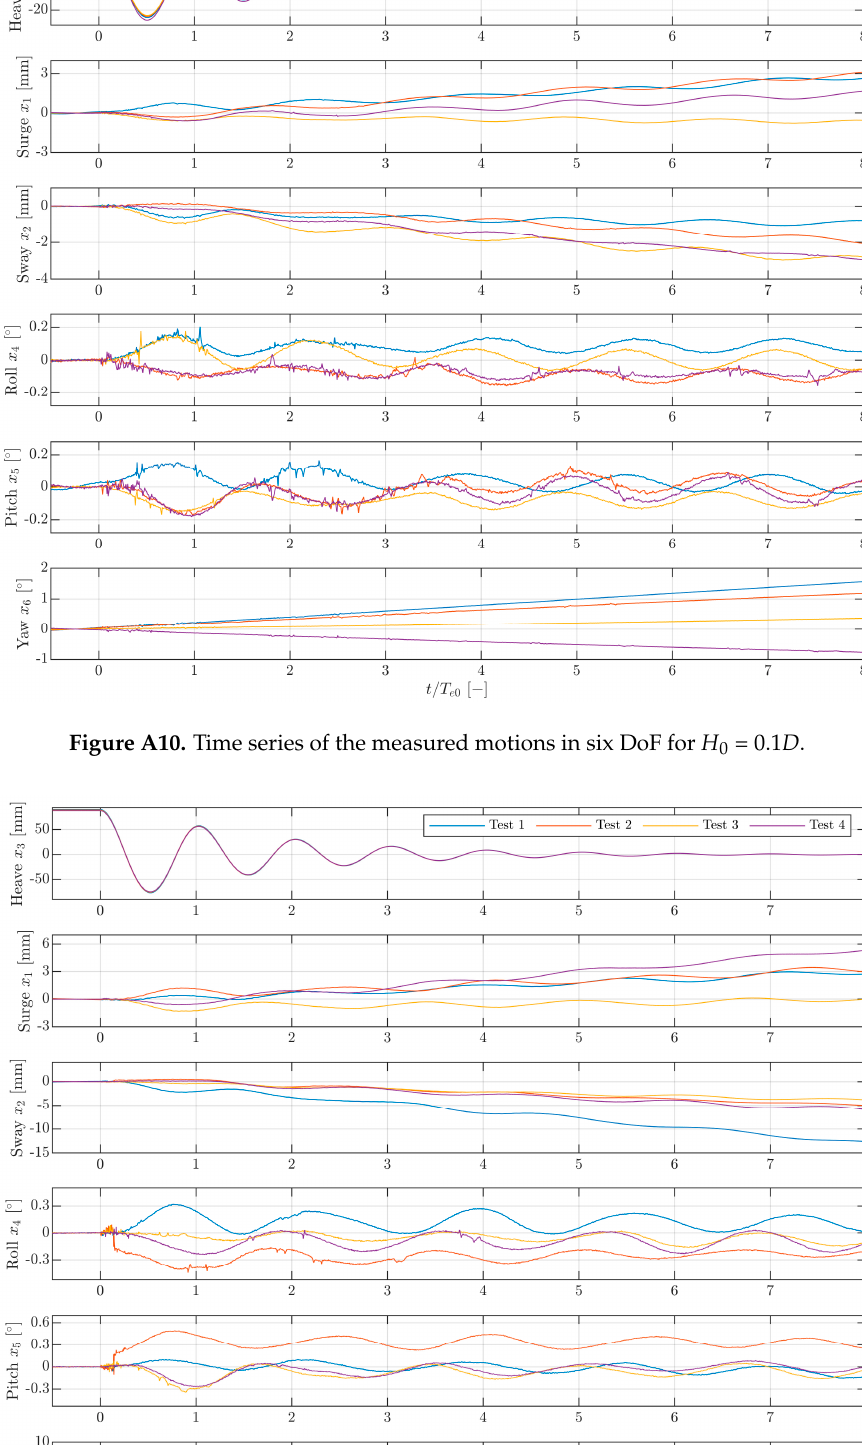
Figure A11. Time series of the measured motions in six DoF for 𝐻 (cid:2868) = 0.3𝐷 .